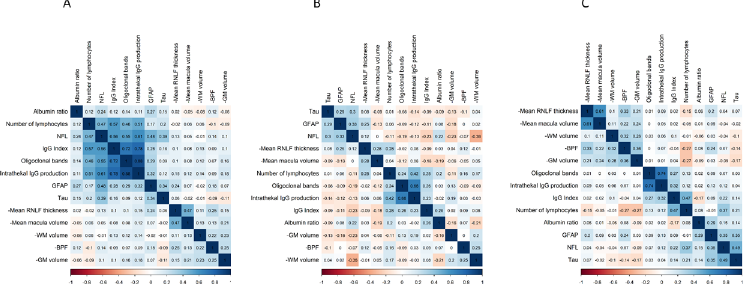
Fig 2. Correlation matrices for biomarkers. Matrices include (A) all patients and controls, (B) only patients with CIS/ RRMS, and (C) only SC and HC groups. Blue: positive correlations; red: negative correlations. Spearman rank correlations are shown as numbers in the cells. The variables are clustered are reordered using hierarchical